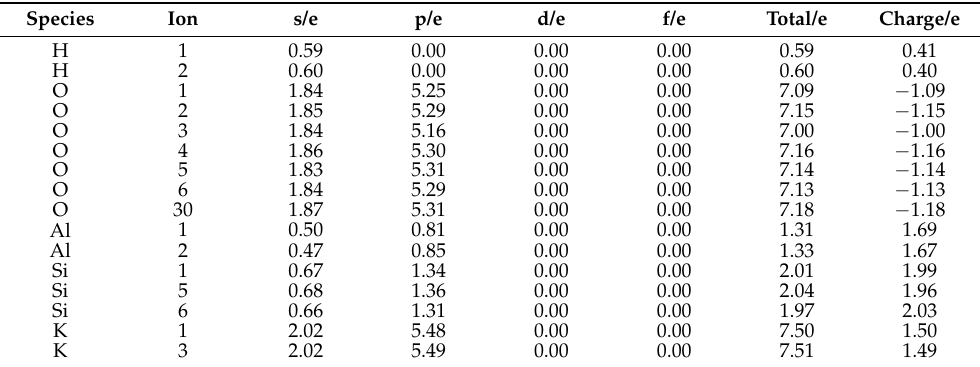
Table 2. The Mulliken population analysis of muscovite